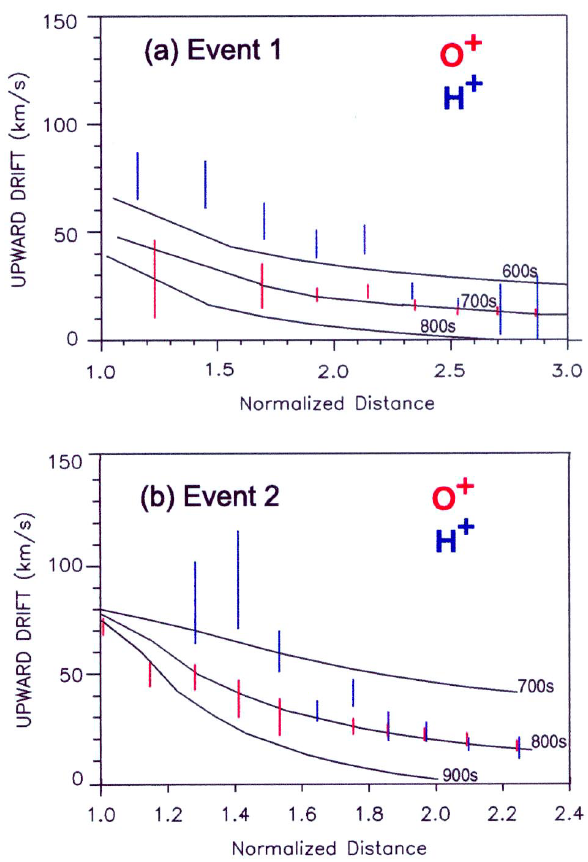
Fig. 6. Comparisons of dispersive patterns of ion upward velocities observed along the satellite track with those from numerical simu- lations using different values of t D